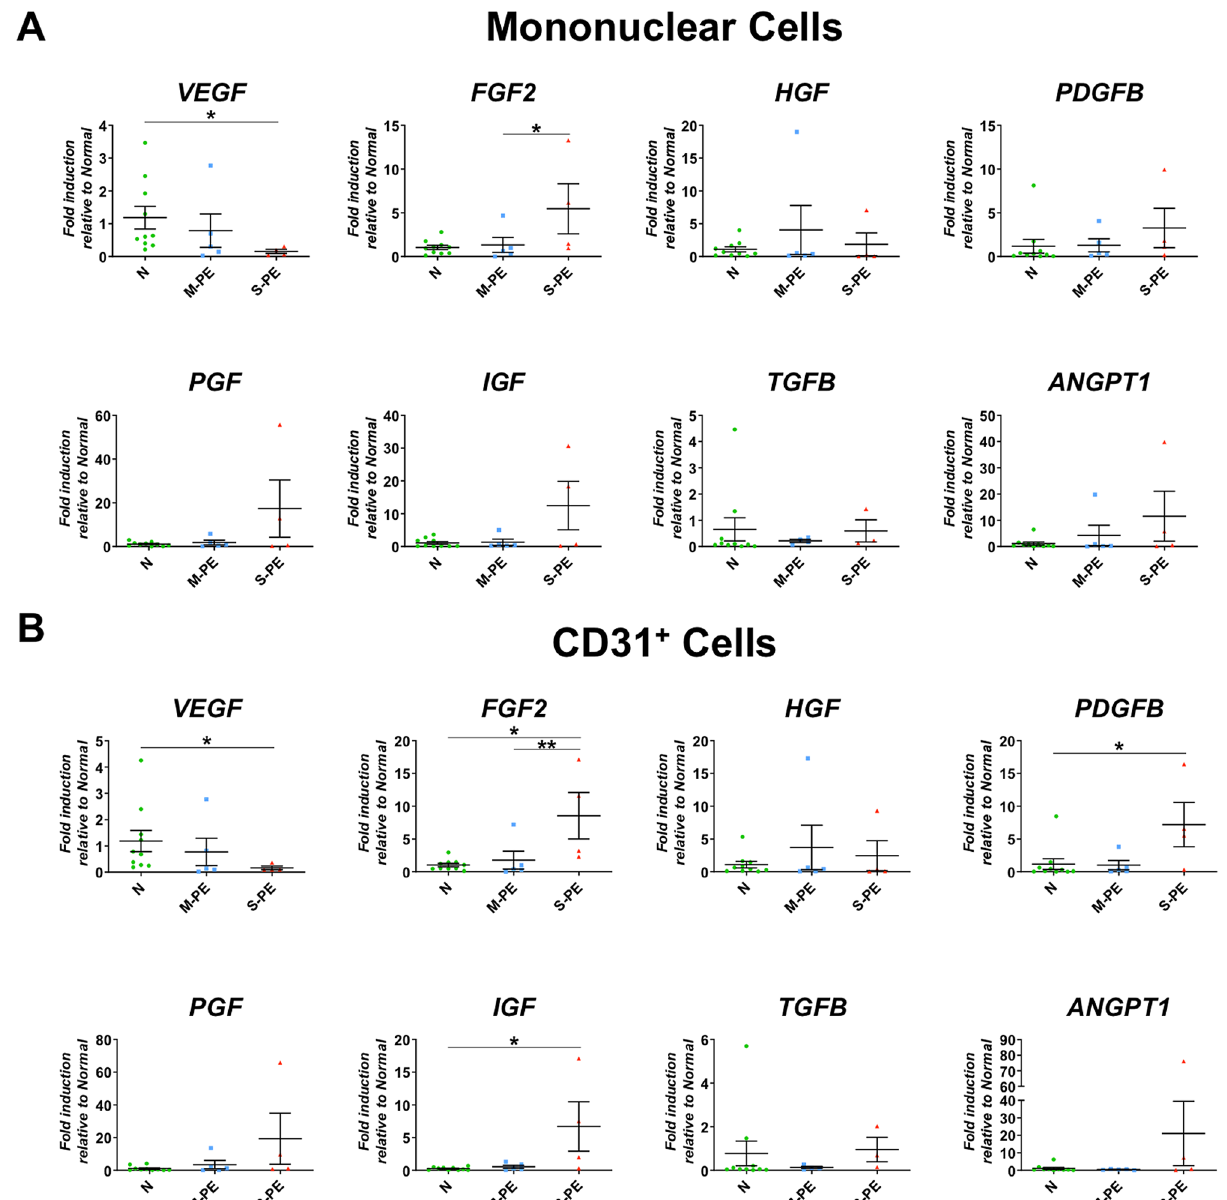
Figure 2. Differential angiogenic gene expression of cord blood mononuclear cells and CD31 + cells between normal, mild PE and severe PE groups. ( A ) qRT-PCR analysis performed on CB-MNCs from normal (n = 10), mild PE (n = 5), and severe PE (n = 4) groups. ( B ) qRT-PCR analysis performed on CB-CD31 + cells from normal (n = 10), mild PE (n = 5), and severe PE (n = 4) groups. Each dot in the plots is the triplicated sample data analyzed by qRT-PCR. Statistical analyses were performed with Kruskal–Wallis test followed by uncorrected Dunn test for pairwise comparison. * P < 0.05, ** P < 0.01, *** P <